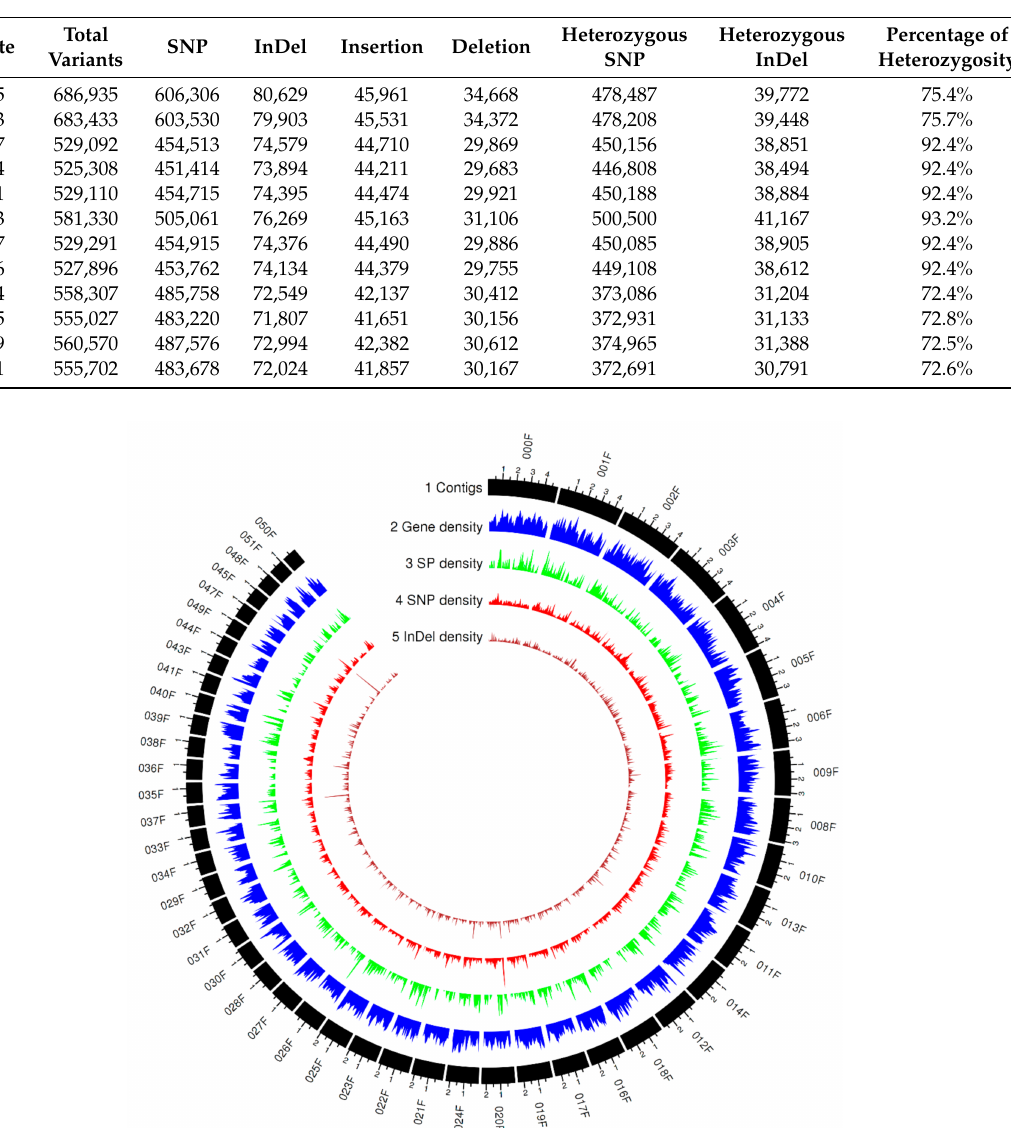
Figure 2. Genomic landscape of predicted genes, secreted proteins with detectable expression level, and genetic variations across 12 Pt isolates represented by the Circos plot of the top 48 contigs ranked by contig length (75.3% of the Pt104 genome). Tracks from outside to inside are: (1) contigs; (2)–(5) density of gene, secreted protein (SP), SNP (single-nucleotide polymorphism), and InDel (insertion